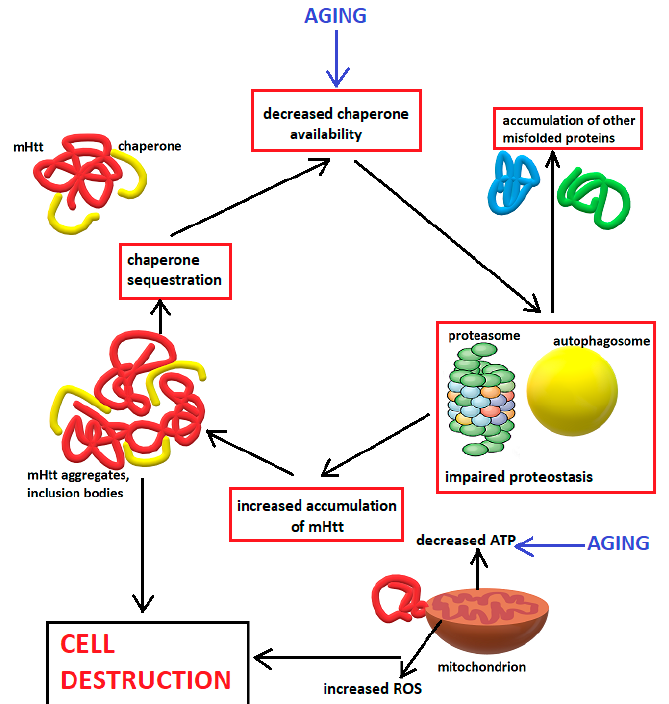
Figure 1. Impaired proteostasis in Huntington’s disease. The chronic production of misfolded huntingtin protein acts synergistically with aging to decrease available chaperones. This leads to accumulation of other misfolded proteins. The mHtt eventually overwhelms the proteasome and impairs the misfolded protein clearance system, an impairment further augmented by the limited availability of ATP due to aging and mHtt-related mitochondrial dysfunction leading to increases in the production of reactive oxygen species (ROS), which, in turn, potentiate mitochondrial dysfunction in a vicious cascade. The accumulation of mHtt promotes its aggregation, further sequestering chaperones in a vicious cycle that disrupts cellular homeostasis and culminates in cell